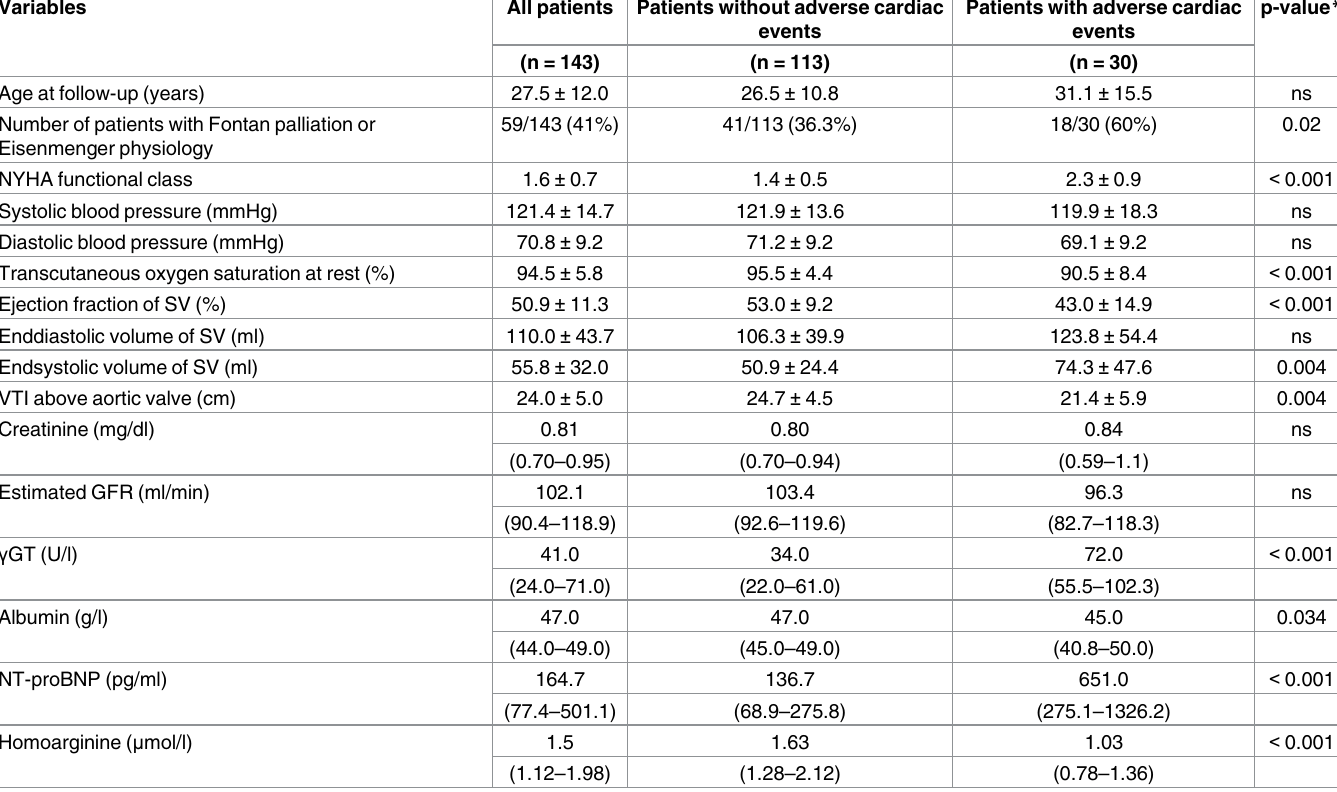
Table 1. Characteristics of patients with and without adversecardiac events #